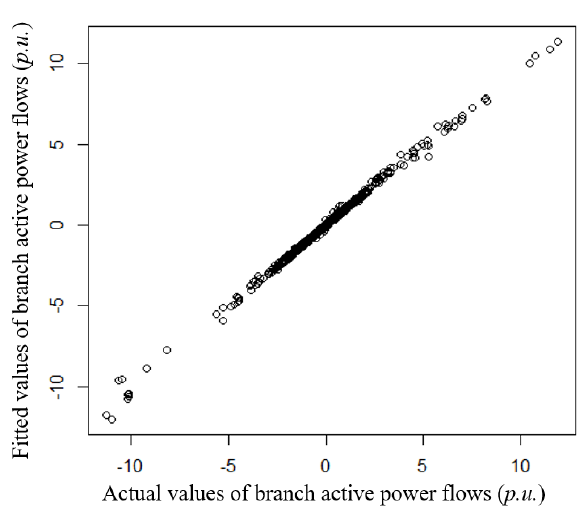
Figure 3. Branch flows of fitted DLAC model versus AC model for hour 1 case .